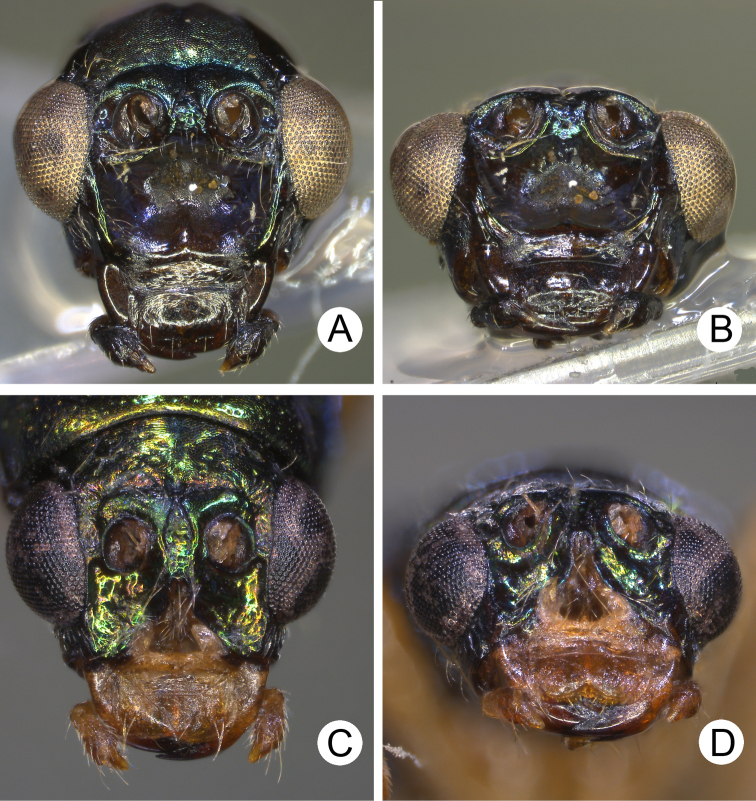
Heads of males of Pseudotheopea
boreri sp. nov. and P.
clypealis. AP.
boreri sp. nov., dorsofrontal view B Same, front view CP.
clypealis, dorsofrontal view D Same, front view.